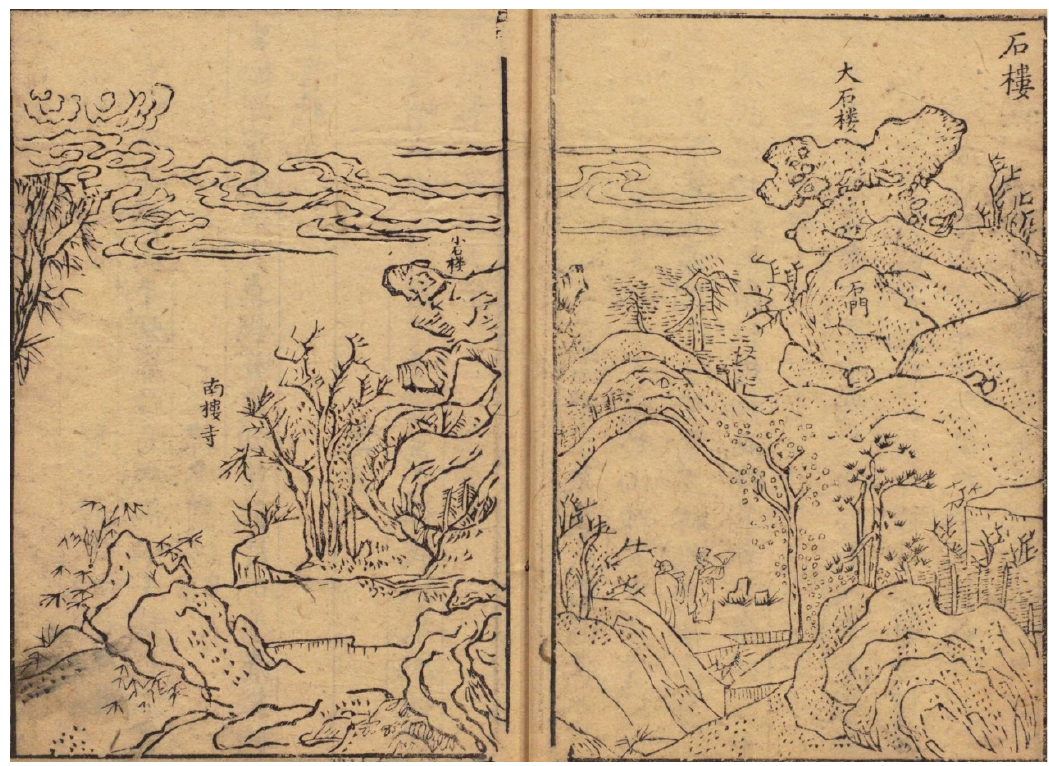
Figure 15. Image of the Nanlou Si, 1607. Woodblock print. After Han Mingluan, Luofu zhi lue , 2.4b-5a.